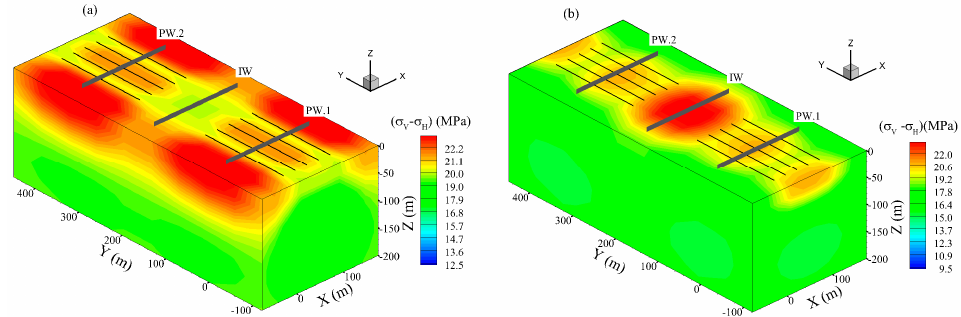
Figure 13. ( a ) Di ff erence between the vertical and the minimum horizontal stresses ( σ V − σ h ) , ( b ) di ff erence between the vertical and the maximum horizontal stresses ( σ V − σ H ) . Positive values of Figure 13 . ( a ) Difference between the vertical and the minimum horizontal stresses ( 𝜎 (cid:3023) − 𝜎 (cid:3035) ) , ( b ) difference between the vertical and the maximum horizontal stresses ( 𝜎 (cid:3023) − 𝜎 (cid:3009) ) . Positive values of the difference between the vertical and horizontal stresses show that after 2 years of the production, the reservoir stress state is still within a normal faulting regime (i.e., 𝜎 (cid:3023) > 𝜎 (cid:3009) > 𝜎 (cid:3035) ).